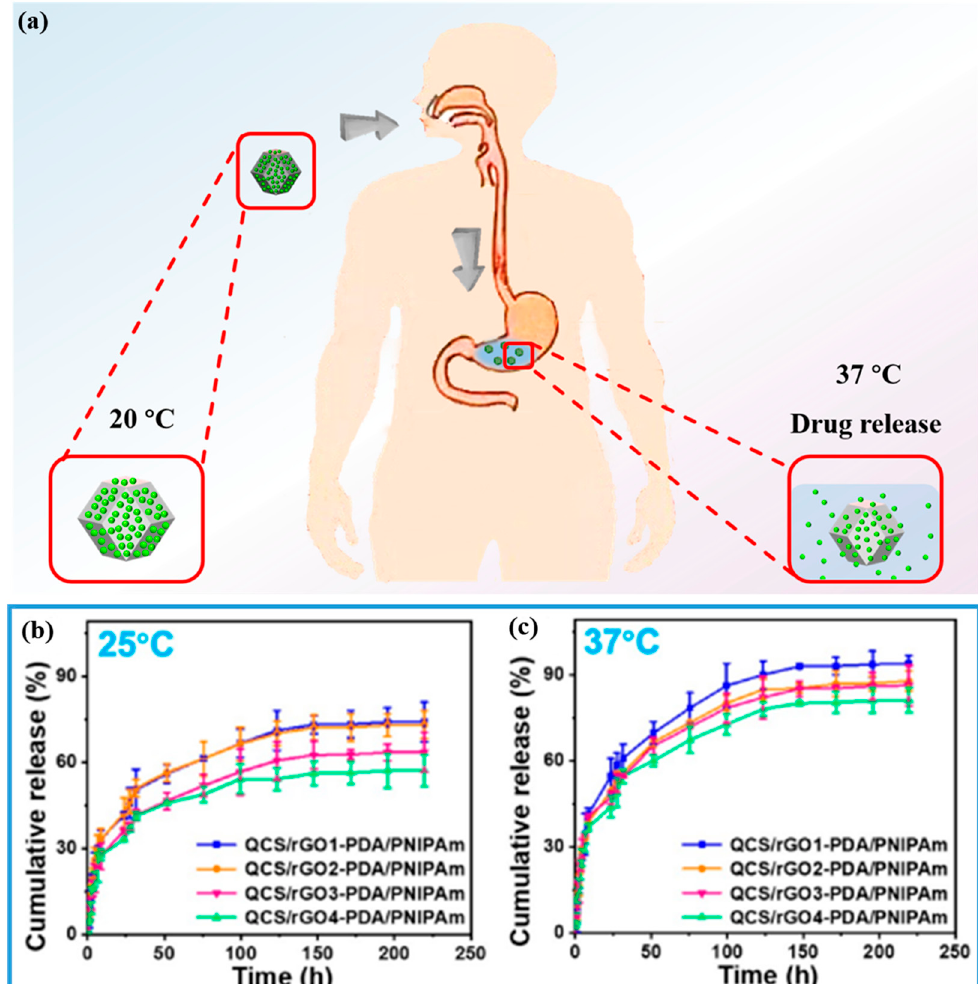
Figure 14. ( a ) Scheme of drug release process of PNIPAM-ECH in vivo. (b) Cumulative release of drug at ( b ) 25 °C and ( c ) 37 °C of PNIPAM-ECH. Copy right from Ref. [89] ACS publications.